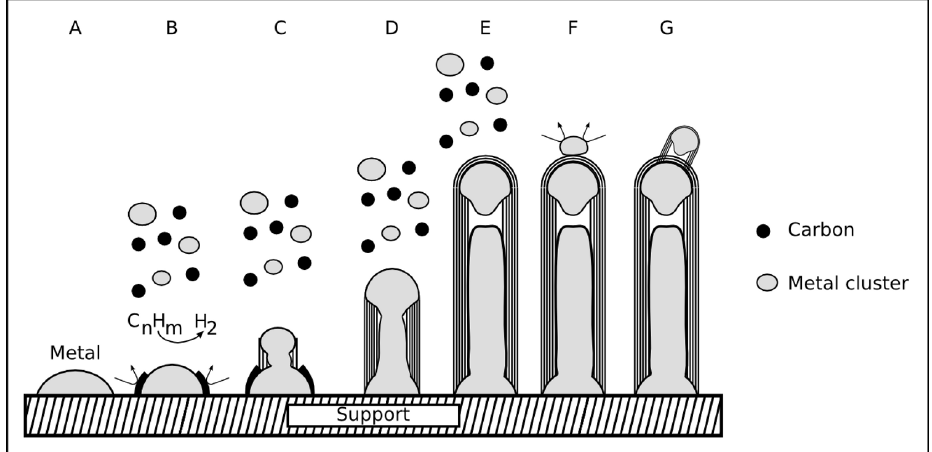
Figure 14. Steps of the combined growth mechanism. In step A a catalyst particle is